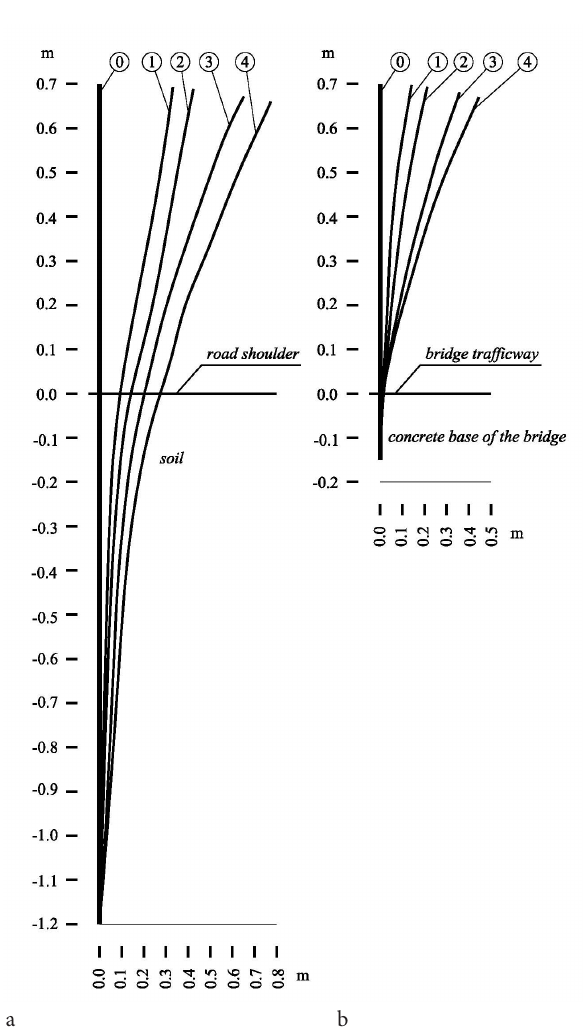
Fig. 5. Deflections of the metal road guardrail posts caused by the impact of a motor vehicle moving at varying speed: a – for guardrail posts mounted on road shoulder; b – for guardrail posts mounted on a bridge (or viaduct); – before interaction; – cross-section is of double T-shape, after interaction, the speed of the motor vehicle is 50 km/h; – cross-section is of Σ-shape, after interaction, the speed of the motor vehicle is 50 km/h; – cross-section is of double T-shape, after interaction, the speed of the motor vehicle is 90 km/h; – cross-section is of Σ-shape, after interaction, the speed of the motor vehicle is 90